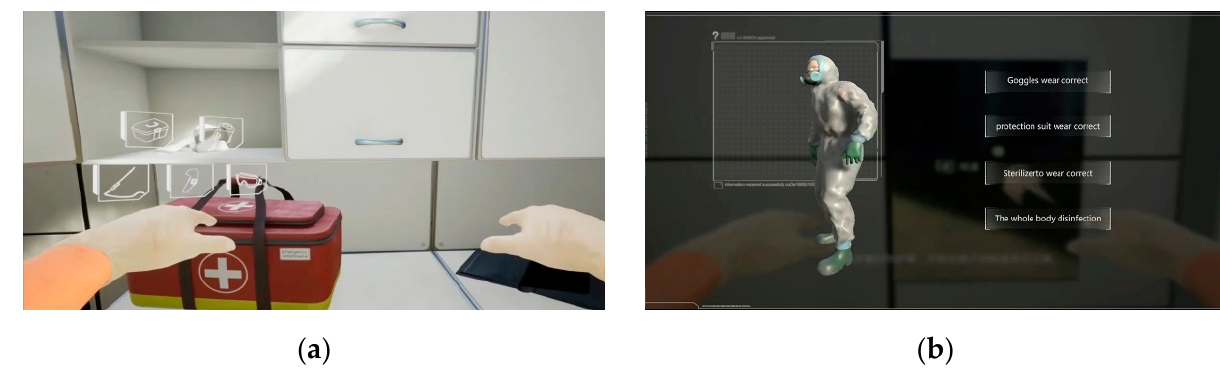
Figure 10. Preparation Module Exploring Flow.